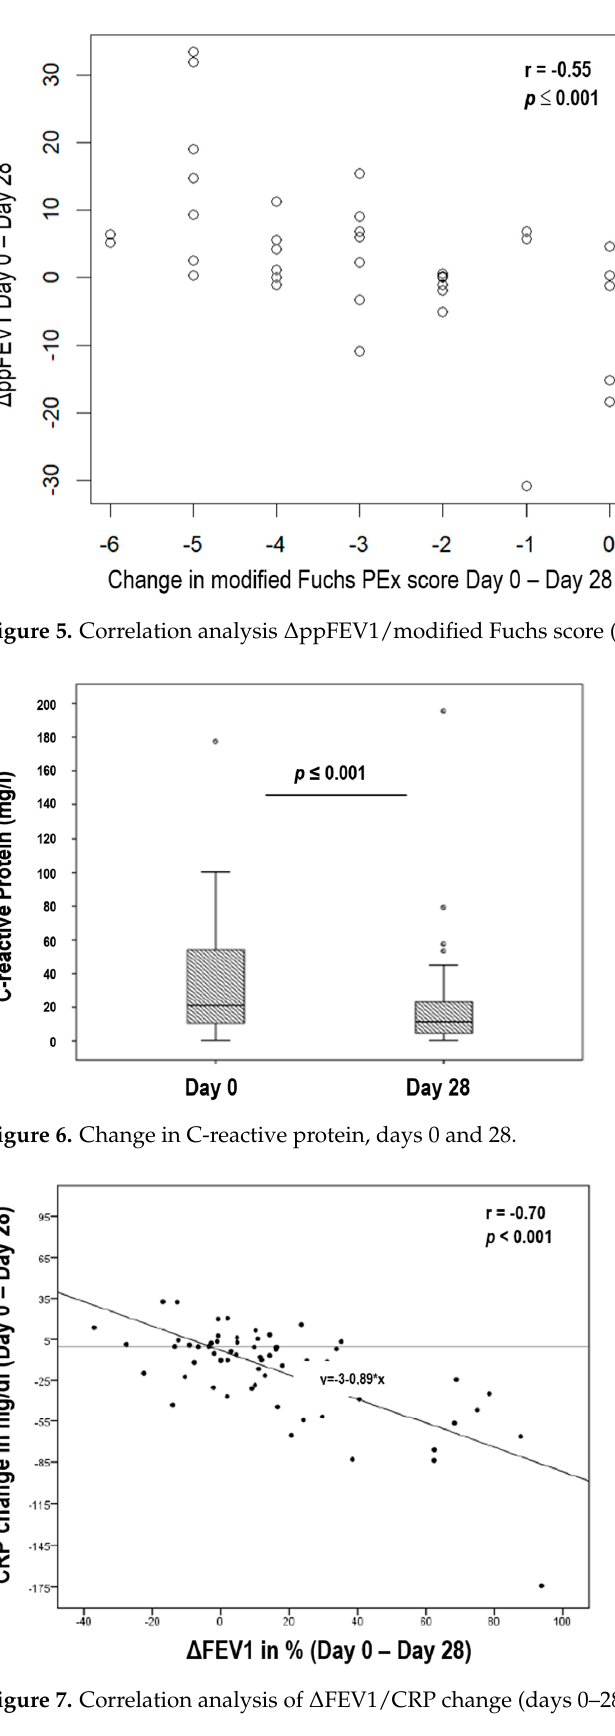
Figure 8. Correlation analysis of Δ FEV1/CFQ-R (days 0–28). 2.3.5. Assessment of Response to Therapy To assess factors in fl uencing response to therapy, we de fi ned a home spirometry FEV1 increase of at least 5% between day 0 and day 28 as successful BEx treatment and a FEV1 increase <5% as a poor response to therapy. According to this de fi nition, 57 patients were classi fi ed as treatment responders, while 39 patients were classi fi ed as non-respond- ers (please see Table 5). A comparison of responders and non-responders in terms of base- line and outcome parameters showed no signi fi cant di ff erences in age, sex, BMI, pancre- atic insu ffi ciency, diabetes, airway colonization, leukocyte count, hospitalization rate, FEV1 at baseline and FEV1 decline in the two years prior to the study, duration of therapy, or inpatient vs. outpatient treatment. A signi fi cant di ff erence between responders and non-responders was seen in the mean baseline CrP at day 0, which was higher in the re- sponder group. In addition, responders showed a signi fi cantly greater decrease in CrP from day 0 to day 28. The responder group had signi fi cantly higher BEx symptom scores on day 0 and a greater decrease in BEx symptom scores between days 0 and 28. The fact that the non-responders started with be tt er baseline values but had a worse therapy out- come could be due to BEx being in fl uenced by factors that do not respond to antibiotic